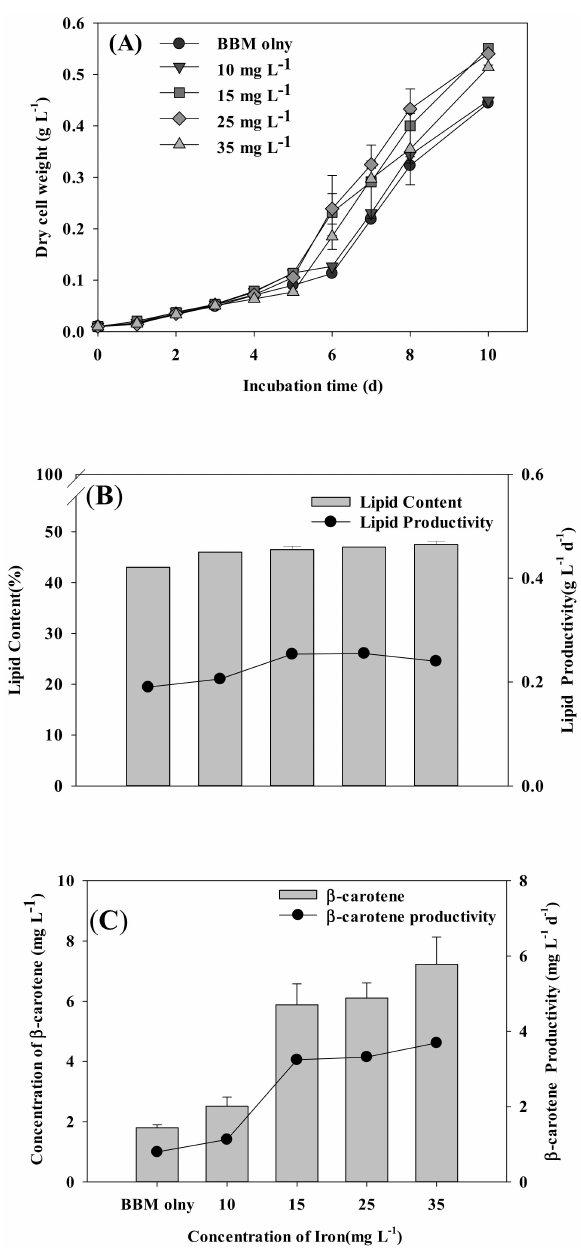
Figure 2. The e ff ect of iron on the growth ( A ), lipid ( B ) and ß-carotene ( C ) of Uronema sp. KGE 3 cultivated in Bold’s Basal Medium